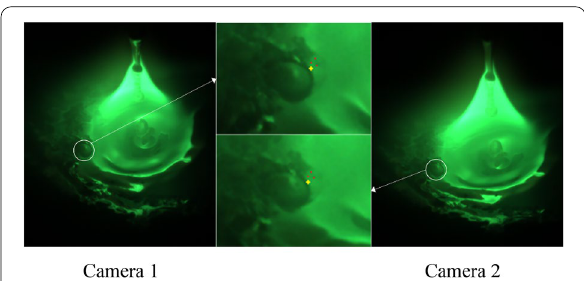
Figure 18 Tracer particle verification (240 A, 33 V, 0.6 m/min)